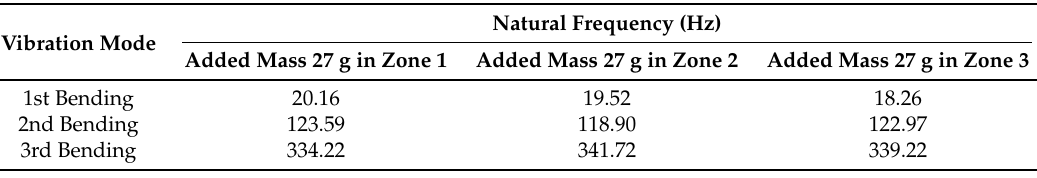
Table 7. Natural frequencies of the beam estimated from experimental modal analysis for the added mass Cases 8–10.